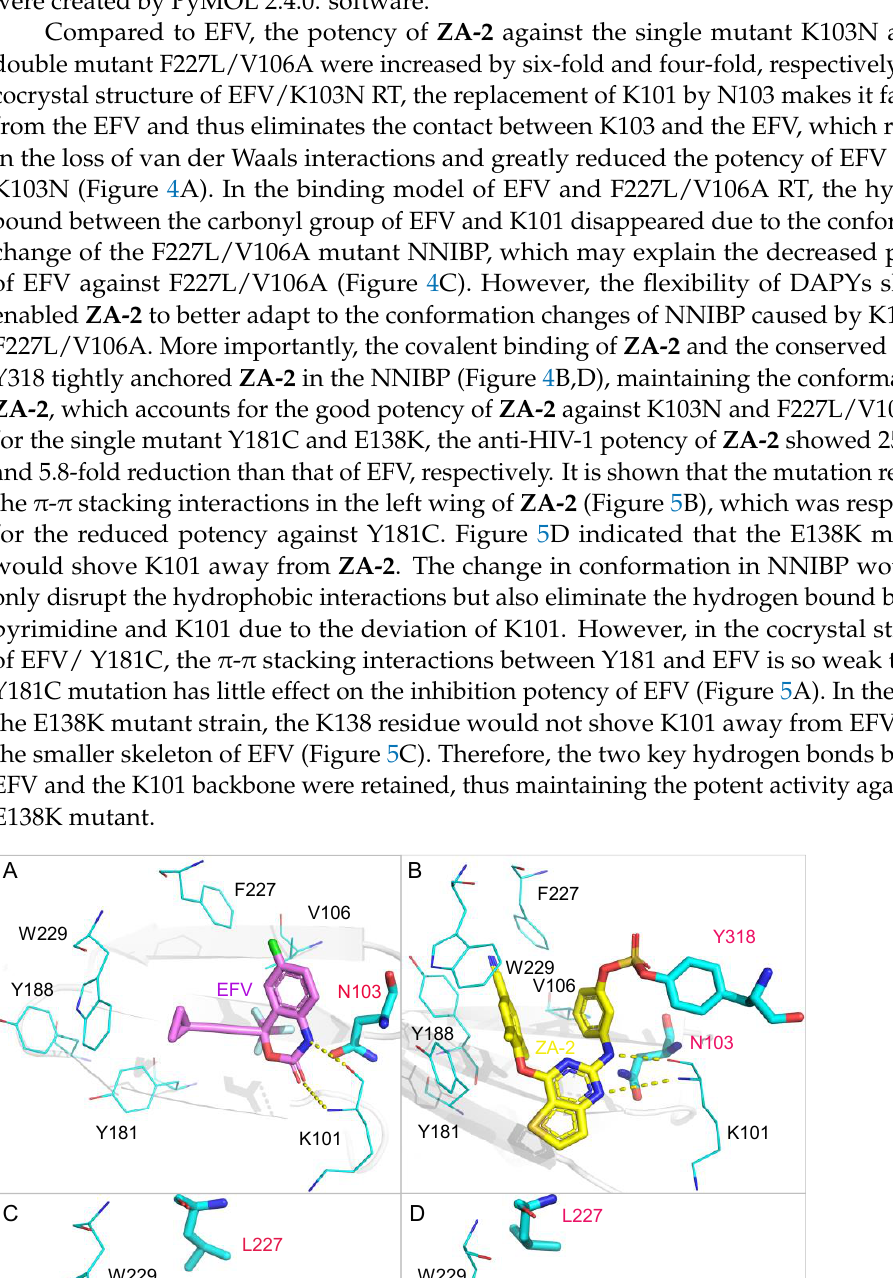
Figure 5. ( A ) The crystal structure of EFV and Y181C HIV-1 RT and ( B ) predicted binding modes of ZA-2 with Y181C HIV-1 RT (PDB code: 1JKH), ( C ) EFV with E138K HIV-1 RT and ( D ) ZA-2 with